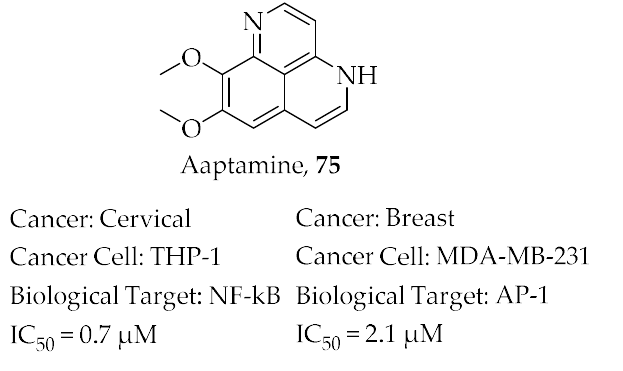
Figure 10. Chemical structure of the benzo[de[1,6]]-naphthyridine alkaloid Aaptamine with a summary of its biological activity towards selected cancer targets.